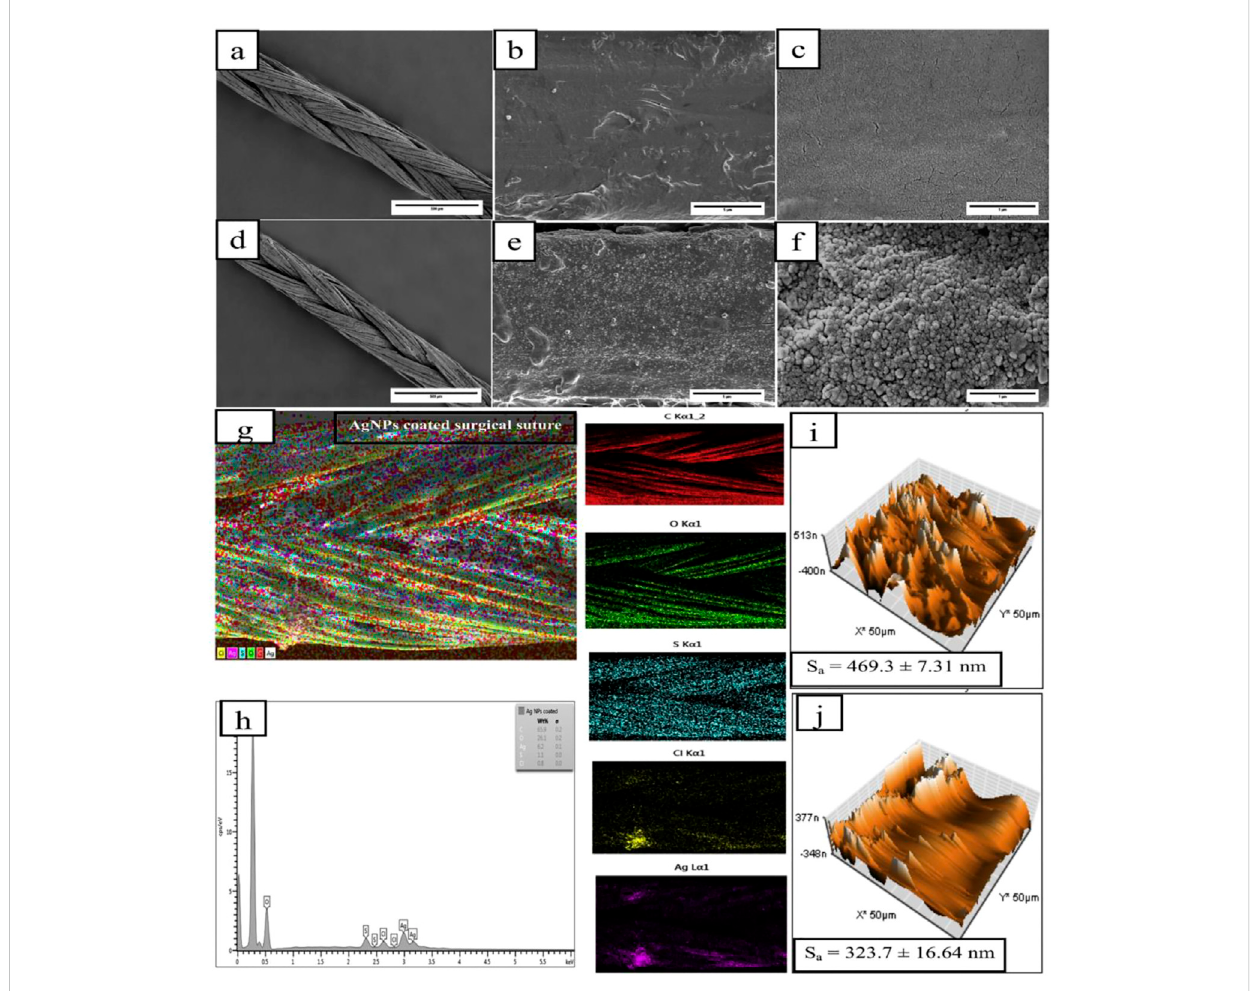
FIGURE 12 Fieldemission scanning electron microscopy imageofbraided (A – C) and uncoated (D – F) MNPs coated surgical suturesatdifferentmagni fi cations. Distribution of MNPs-coated surgical sutures using energy dispersive x-ray (G, H) . Surface roughness of uncoated (I) and MNPs-coated (J) surgical sutures using atomic force microscopy. Reproduced with permission from Syukri et al. (2020). Copyright 2020,